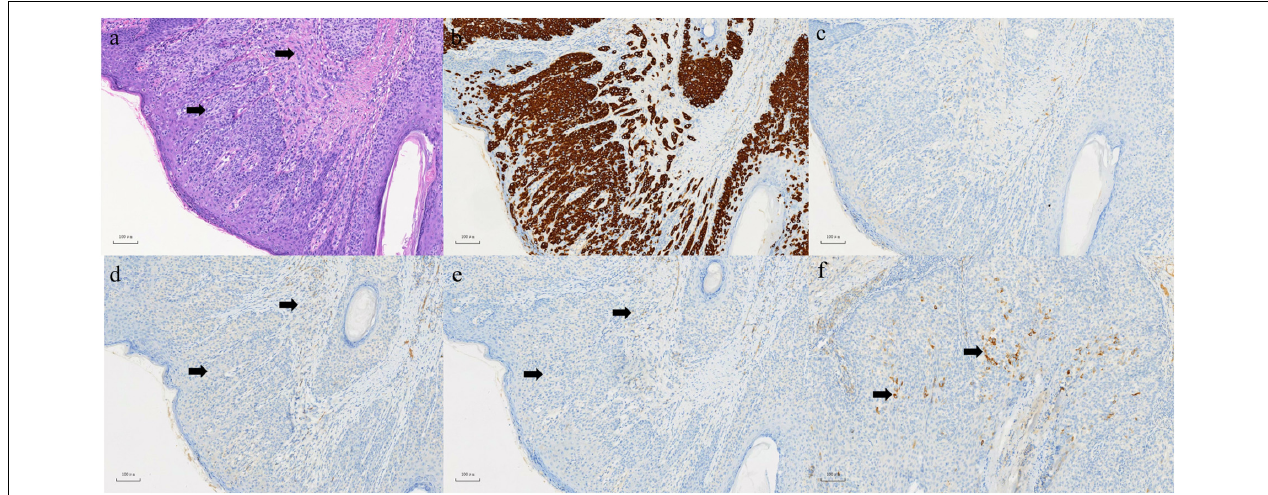
FIGURE 3 | (a) In epidermis and dermis, there are abundant pale-staining cytoplasmic, which are flaky, small nests or scattered cells in HE staining, involving both the dermis and skin appendages. Left arrow: Paget cell. Right arrow: infiltrating adenocarcinoma. (b) Positive expression of CK (7) in EMPD section